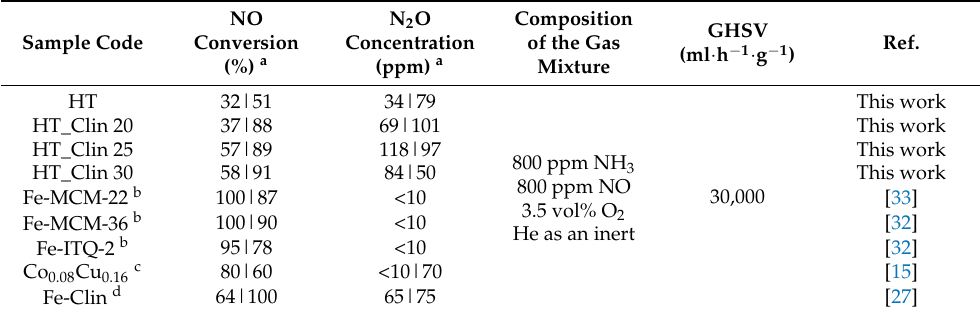
Table 4. Comparison of the catalytic performance of HT-Clin samples with other catalysts tested under similar reaction